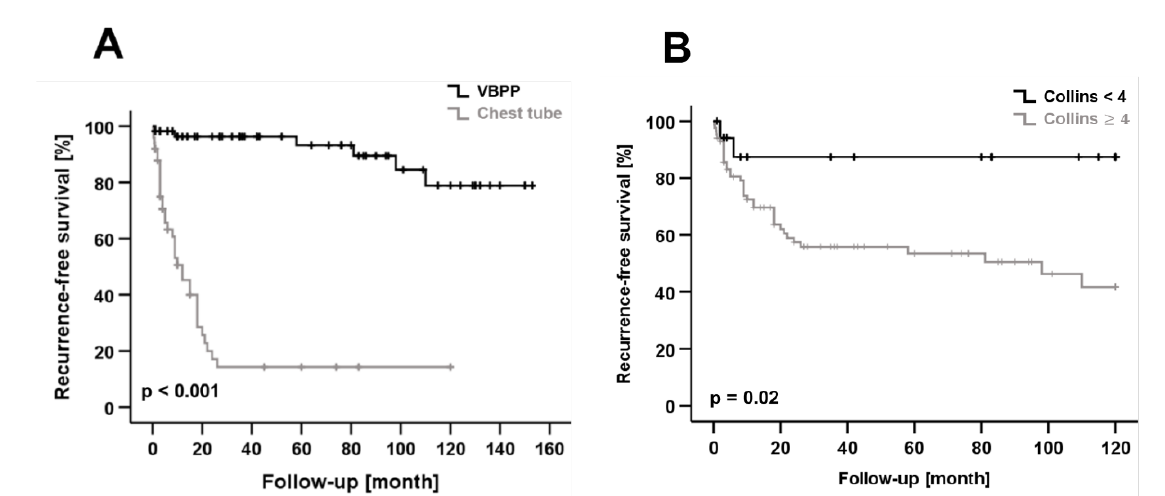
Figure 1. ( A ) Kaplan – Meier curve shows recurrence-free survival (RFS) after treatment by surgery (VBPP) or chest tube (CT). VBPP was associated with significantly better RFS compared to CT treatment. ( B ) Patients with a large pneumothorax size (Collins ≥ 4 cm) had a significantly reduced RFS compared to patients with a small pneumothorax size (Collins < 4 cm). Table 4. Multivariate analysis of potential risk factors for recurrence of PSP. Risk Factor Hazard Ratio Treatment